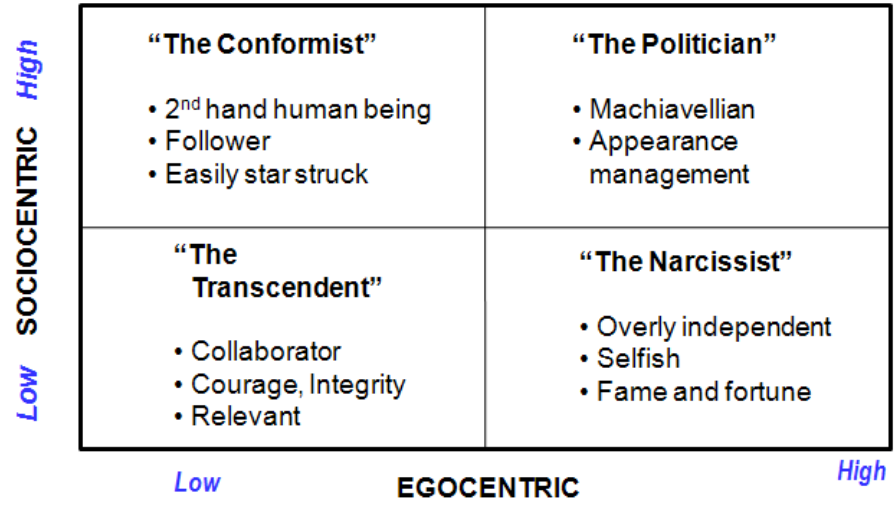
Figure 2: A caricature of the ‘other’ academic’s